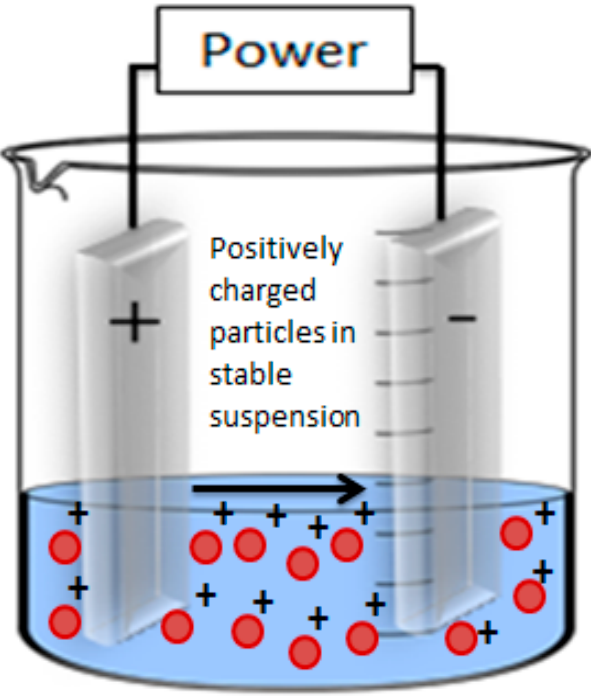
Figure 1. General setup of EPD process.